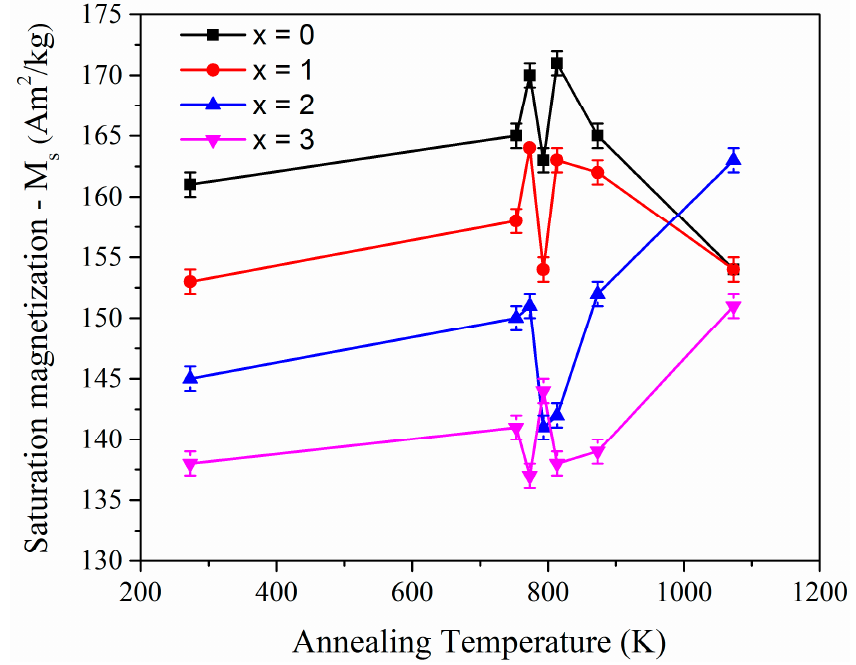
Figure 9. Variation of saturation magnetization ( M s ) as a function of temperature for Fe 76 Si 9 − x B 10 P 5 Mo x ( x = 0, 1, 2 and 3) glasses.